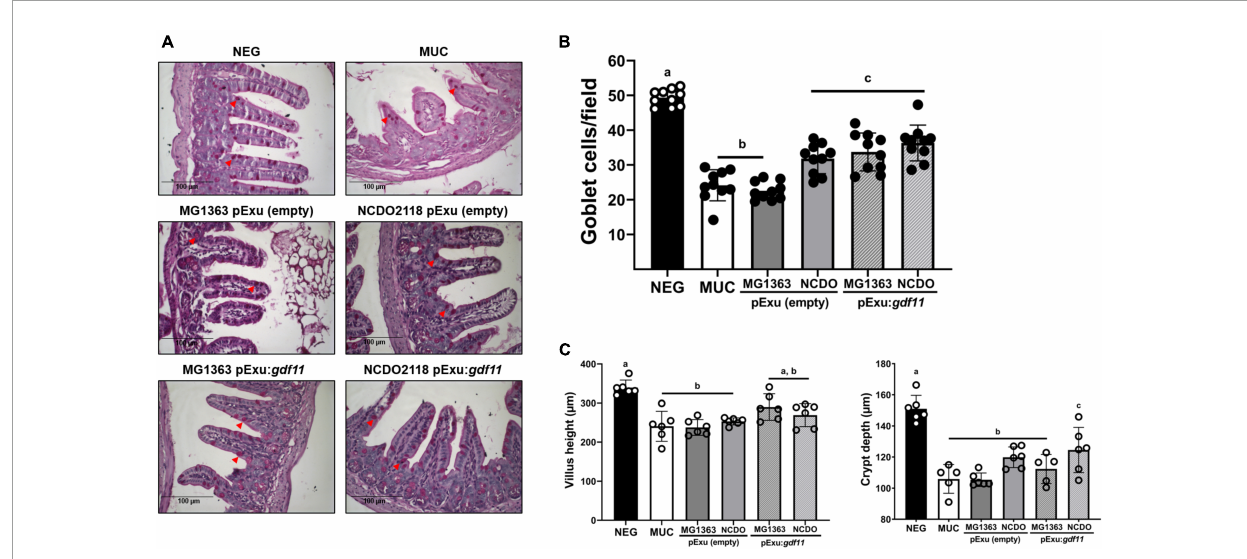
FIGURE3 Protective effect of recombinant L. lactis (pExu: gdf11 ) on goblet cells number in the intestinal mucosa and average villus height ( µ m) and crypt depth of mice that received 5-FU for induction of intestinal mucositis. (A) Representative photomicrographs from the ileum section stained with Periodic-acid-Schiff (PAS). Red arrowheads indicate intact goblet cells in the tissue (40x objective, 100 µ m scale). (B) Average number of goblet cells per field encountered in experimental groups ( n = 6). Different letters (a, b, and c) indicate a significant difference ( p < 0.05) among groups by one-way ANOVA and Tukey’s post-test. (C) Mice ( n = 6) presented villus shortening and crypt depth reduction as a consequence of 5-FU administration. Different letters (a, b, and c) indicate a significant difference ( p < 0.05) among groups by one-way ANOVA and Tukey’s post-test.